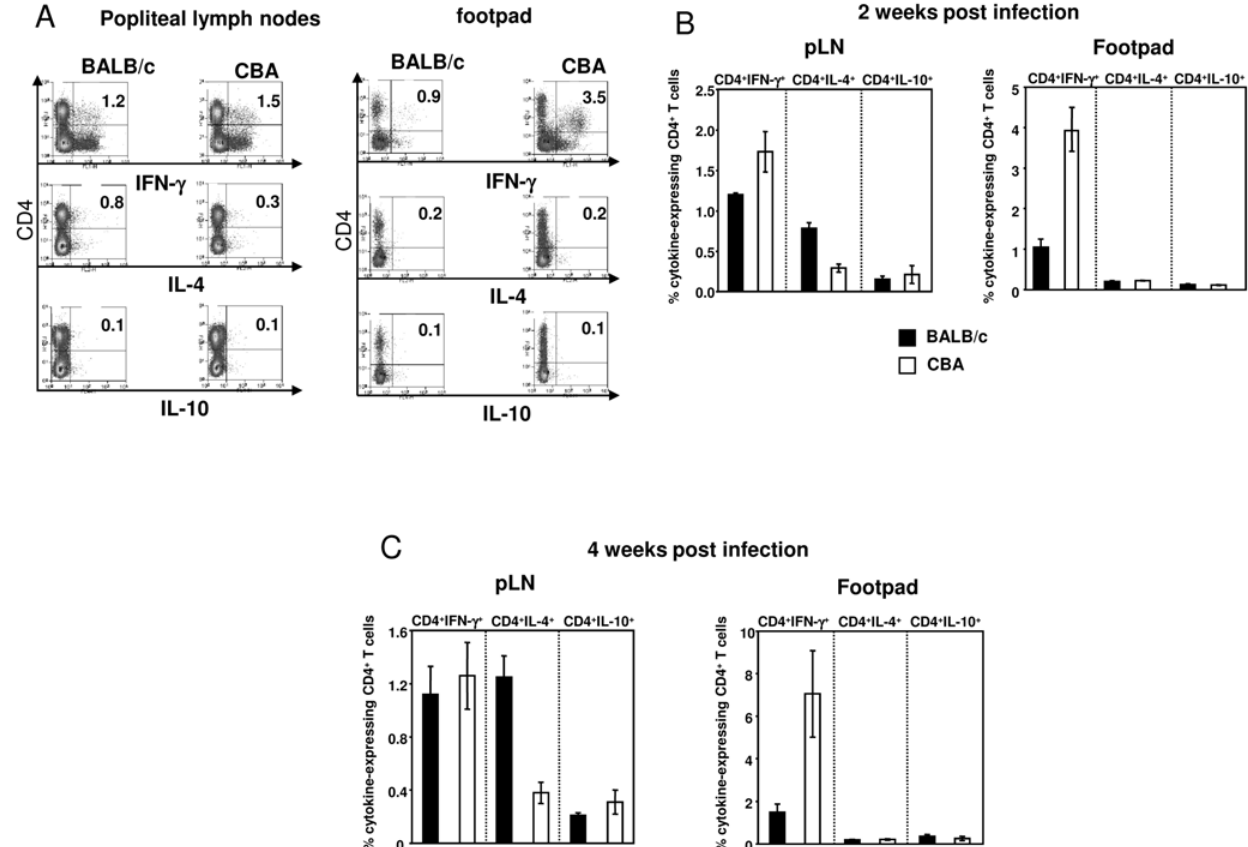
Figure 3. Impaired capacity of antigen-specific CD4 + T cells to express cytokines. Groups of BALB/c and CBA mice (n=8) were infected with L. major parasites for two (A and B) or four (C) weeks. Individual popliteal lymph nodes and footpads (pool from at least two footpads) were harvested and the % of cytokine-expressing CD4 + T cells was determined by flow cytometry. (3A) dot plot profiles of cytokine-expressing CD4 + T cells isolated from the popliteal lymph nodes and the footpads two weeks post infection; (3B) % of cytokine-expressing CD4 + T cells two weeks post infection. (3C) % of cytokine-expressing CD4 + T cells four weeks post infection. Error bars represent standard deviations. Isotype control for IFN- c : 0.23 6 0.05%, IL-4: 0.31 6 0.08% and IL-10: 0.26 6 0.06%. All cytokines were below the detection limit when the cells were stimulated in the absence of PMA/ionomycin stimulation. The detection limits were defined as % isotype control + 3 standard deviations: IFN- c =0.38%, IL-4=0.55% and IL- 10=0.44%. Data show the results of one representative experiment out of three independent